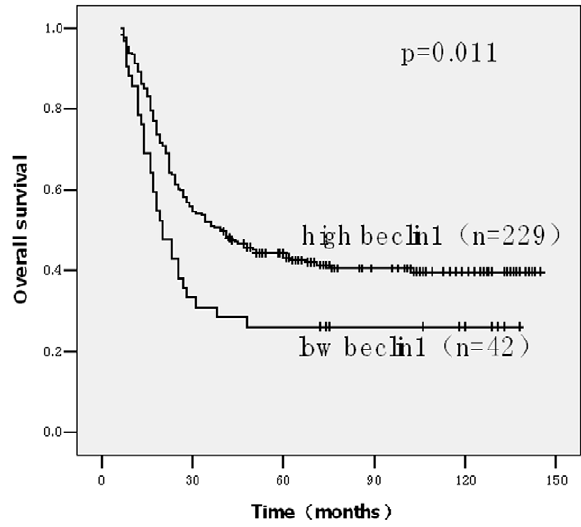
Figure 3. Kaplan-Meier estimates of the probability of survival. Patients with high expression Beclin 1 showed significantly longer overall survival than those with Beclin 1 low expression. (p=.011).